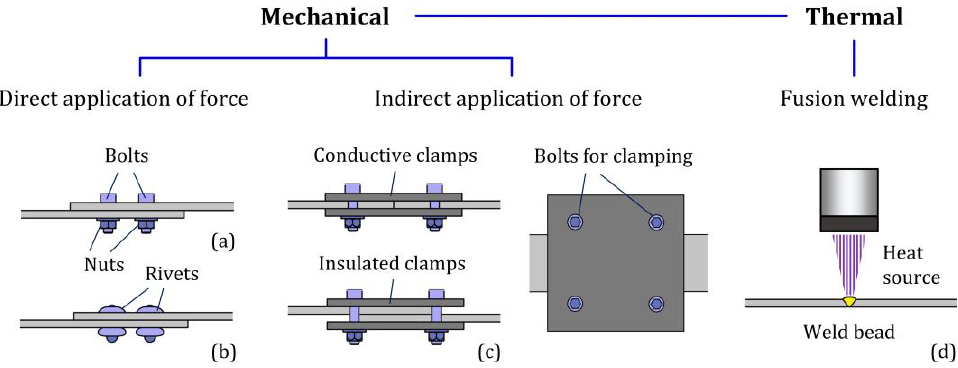
Figure 1. Types of joints used in busbar power distribution systems: ( a ) bolted joints, ( b ) riveted joints, ( c ) clamped joints, and ( d ) welded joints.